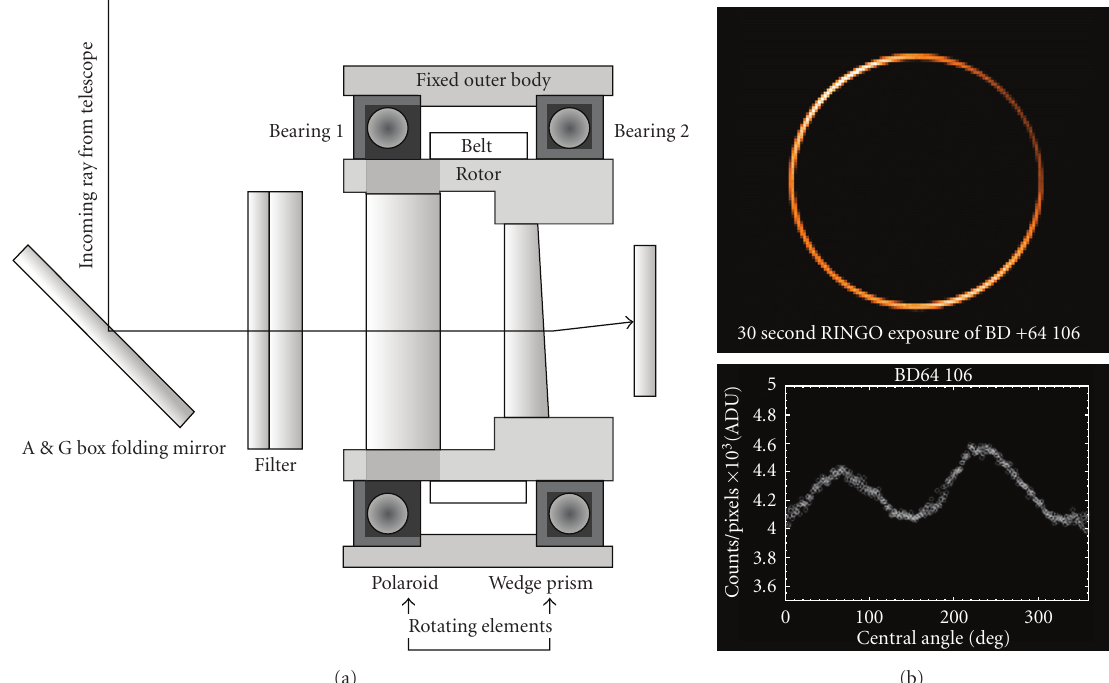
Figure 8: (a) Diagram illustrating design of RINGO. (b) Polarised star BD +64 106 observed through RINGO (top panel): calibrated trace around ring showing polarisation signature (from